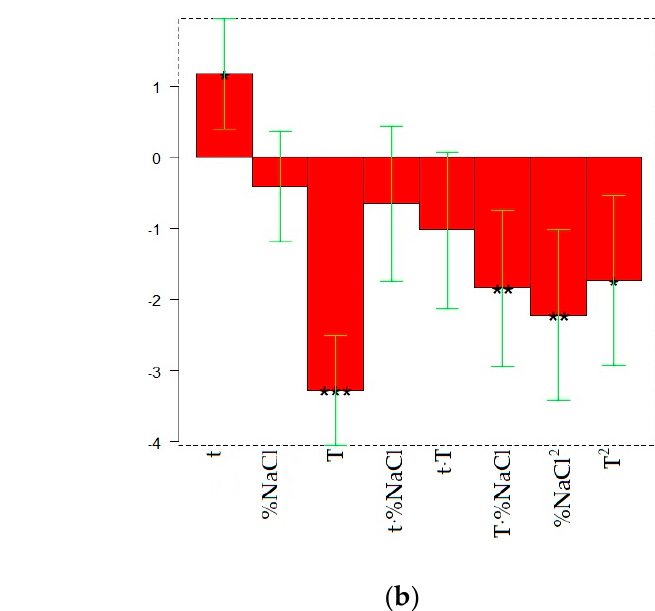
Figure 1. Optimization of HS-SPME profiling of wine volatiles extracted with the PDMS fiber : ( a ) response surface for the total area of the GC chromatogram (A TOT ) at t = 30 min; ( b ) coefficients of the surface model; p < 0.05 (*), p < 0.01(**), p < 0.001 (***).